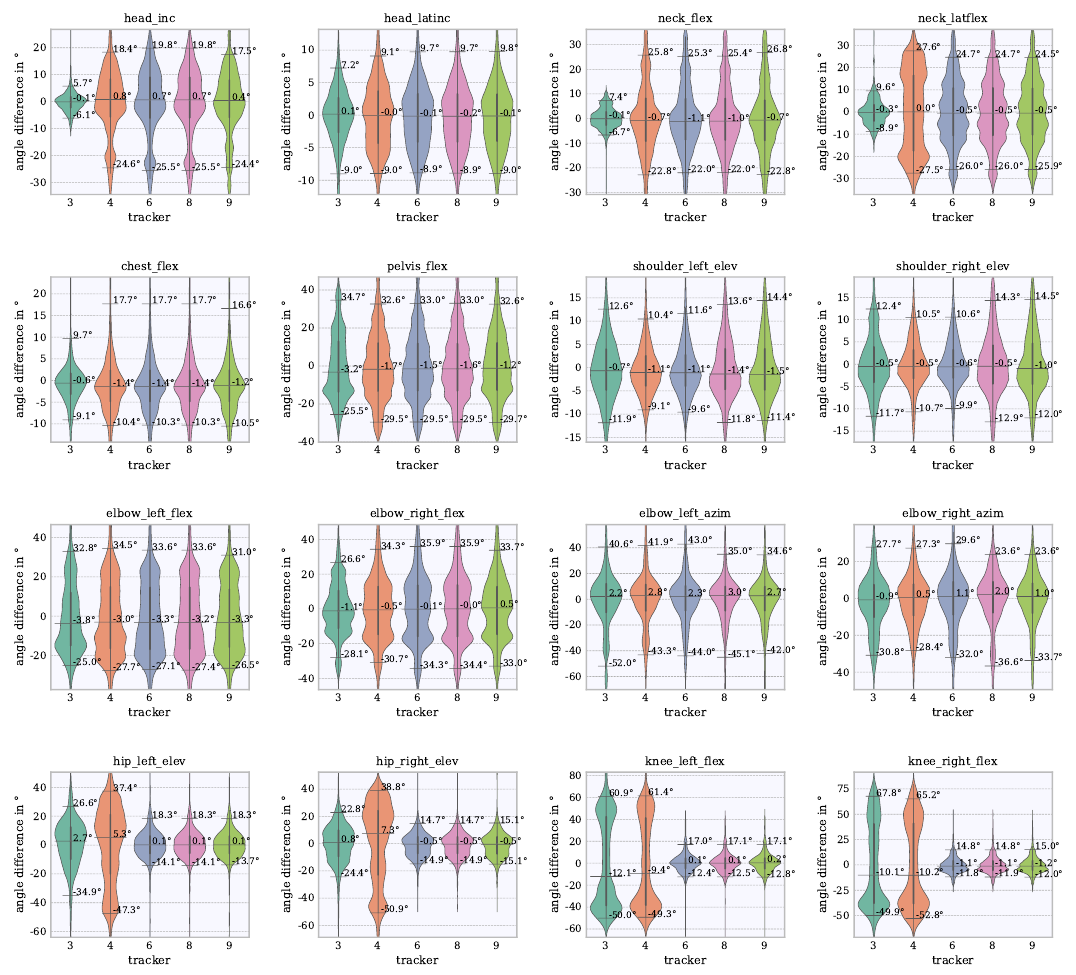
where σ qv is the covariance, µ q , µ v are the mean values and µ q , µ v are the standard devi- ations from q Qualisys and v Vive. According to [37], correlations < 0.90 are evaluated as poor, > 0.90 to < 0.95 as moderate, > 0.95 to < 0.99 as substantial and > 0.99 as almost perfect. An example of how the CCC behaves with a scale shift between two signals can be explained with the help of Figure 8a. In the upper graph, the CCC is 0.9 for a scale-shifted signal (Vive, Qualisys). The lower graph shows that the CCC increases to 0.978 when the shift between the signals is corrected.